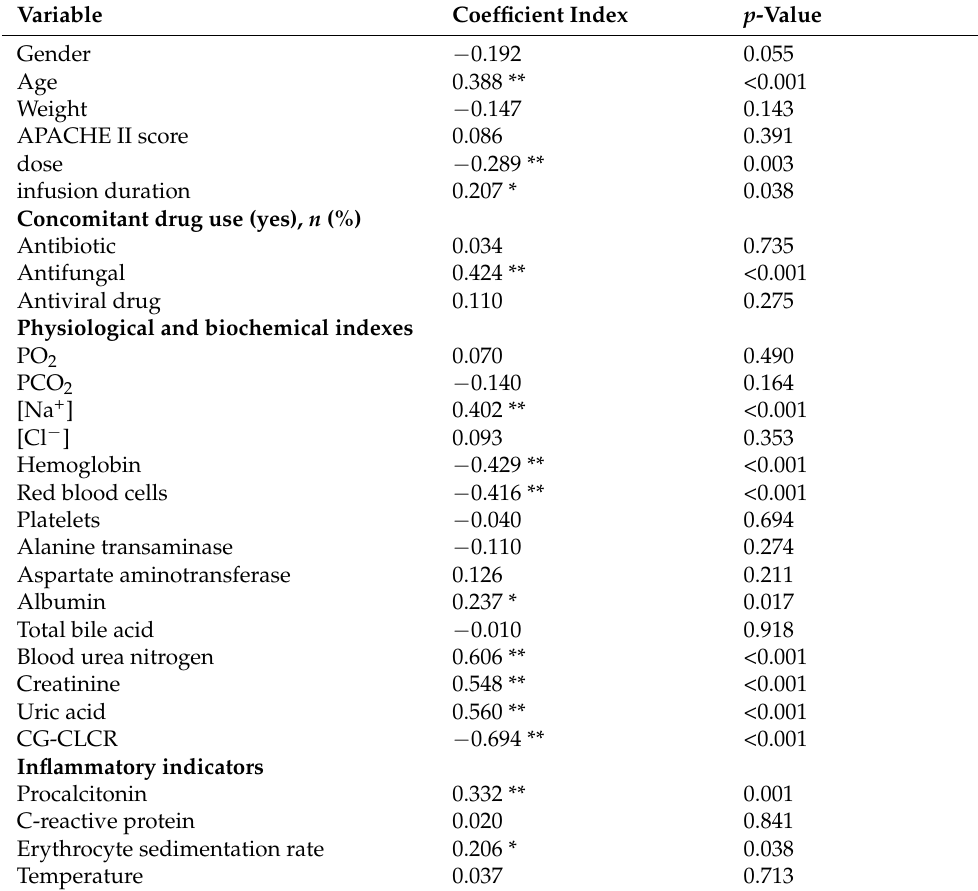
Table 2. Correlation analysis of ln (C trough